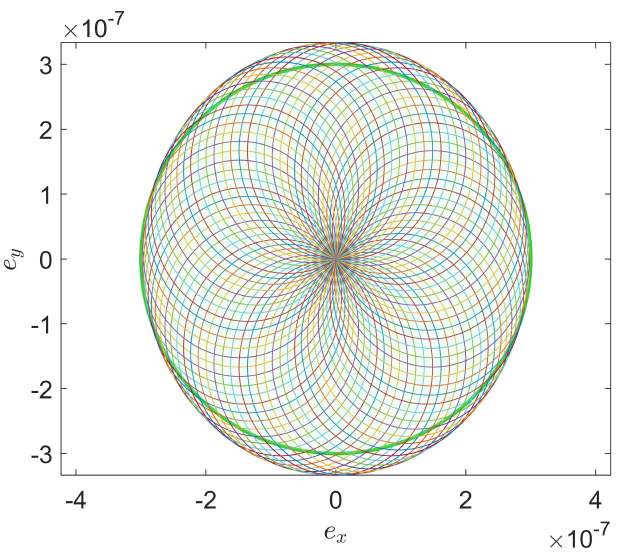
Figure 12. A total of 72 curves of f ( e x , e y ) perturbed by solar radiation pressure for l s 0 = 5 n deg, the integral n ∈ [ 0,72 ] , in a Saturnian year with initial eccentricity vector ( e x eccentricity perturbation limited circle whose radius r = 3 × 10 − 7